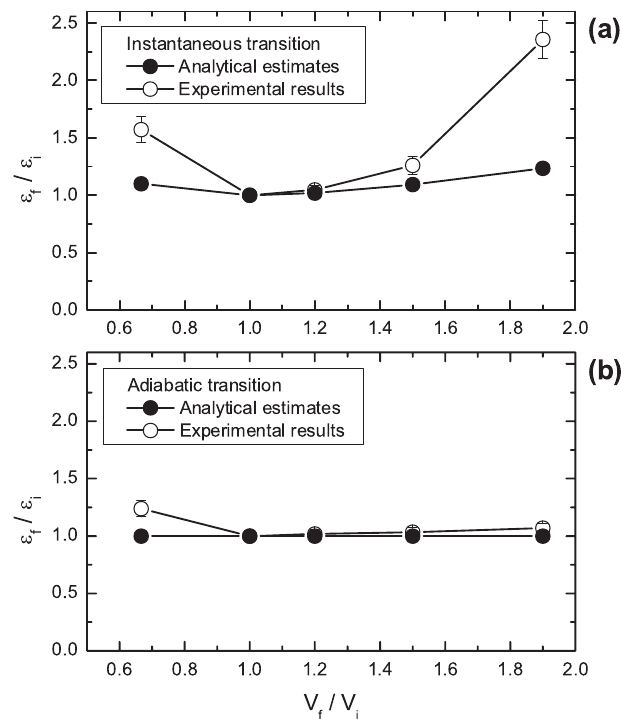
FIG. 10. Plots of the ratio of final to initial transverse emit- =(cid:2) =V =(cid:2) for different values of V . The values of (cid:2) are tance (cid:2) f i f i f i either estimated based on analytical theory (solid circles), or inferred from experimental data (open circles). The two cases correspond to (a) instantaneous transitions, and (b) adiabatic (cid:2) 49 : 8 (cid:3) and f (cid:2) 60 kH z transitions. Here, (cid:5) sf vi